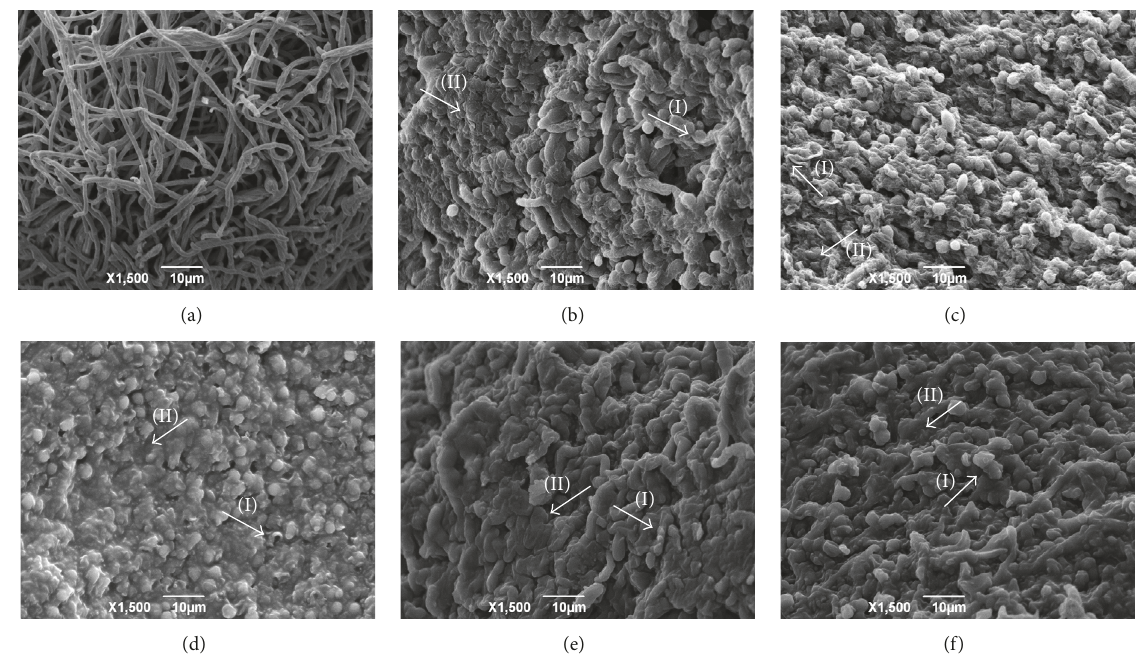
Figure 1: Electron micrographs of T. mentagrophytes ATCC 9538 exposed or not to the reference drugs and hexahydropyrimidine derivative of interest. (a) T. mentagrophytes ATCC 9538 not subjected to pharmacological treatment; (b) T. mentagrophytes ATCC 9538 subjected to treatment with terbinafine; (c) T. mentagrophytes ATCC 9538 subjected to treatment with ketoconazole; (d) T. mentagrophytes ATCC 9538 subjected to treatment with HHP1; (e) T. mentagrophytes ATCC 9538 subjected to treatment with HHP3; (f) T. mentagrophytes ATCC 9538 subjected to treatment with HHP4. Arrows indicate the appearance of wrinkled (I) and crushed (II) hyphae.